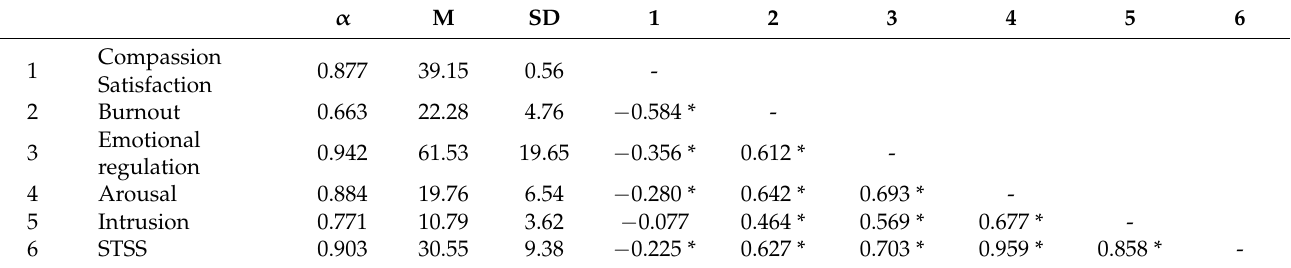
Table 2. Preliminary analysis: Cronbach’s α , means, standard deviation, and correlations. α